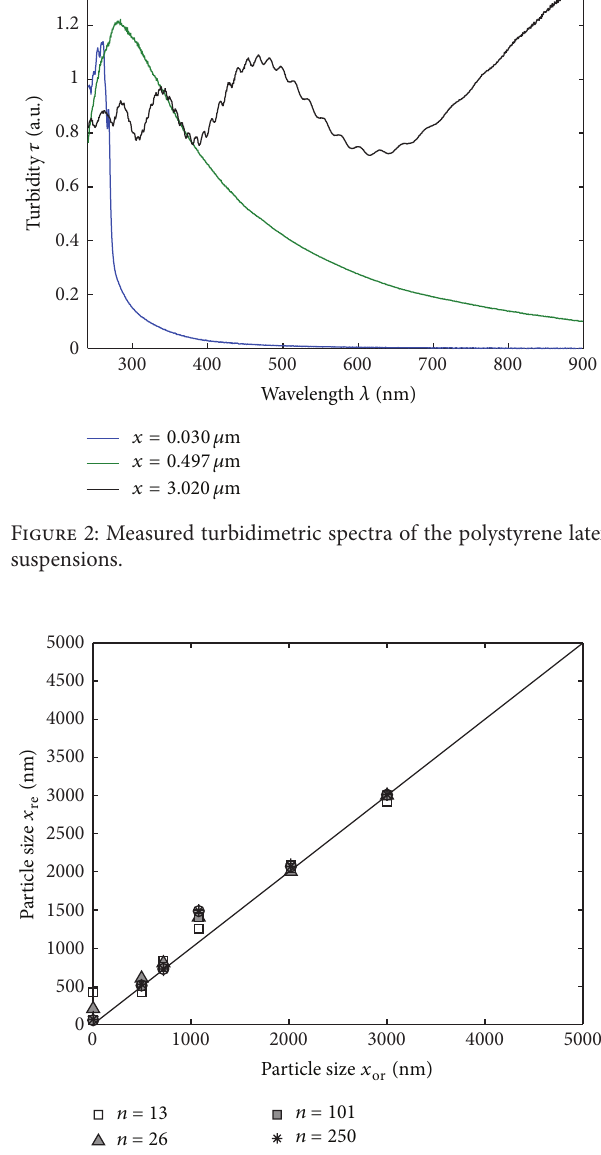
and retrieved 𝑥 modal or re